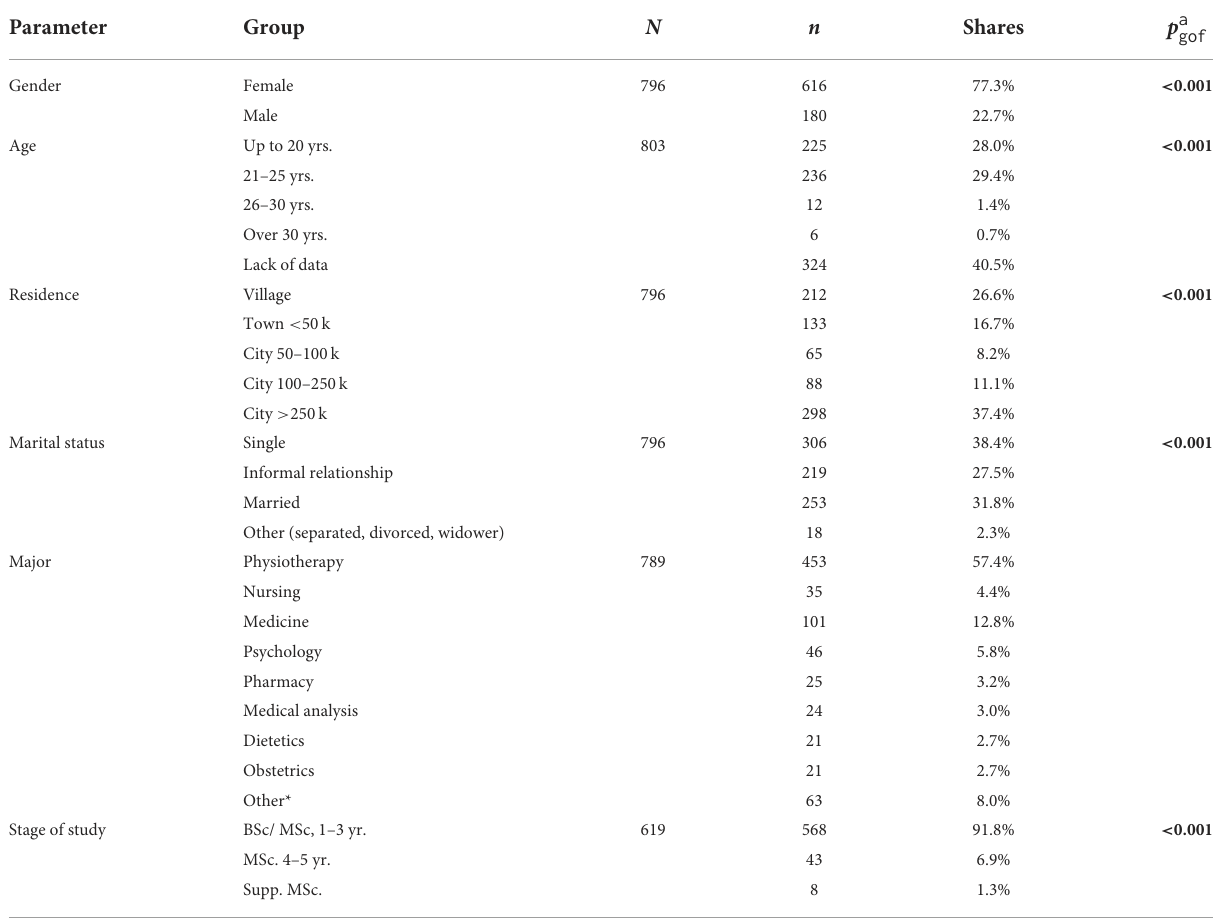
TABLE 2 Characteristics of the sample.